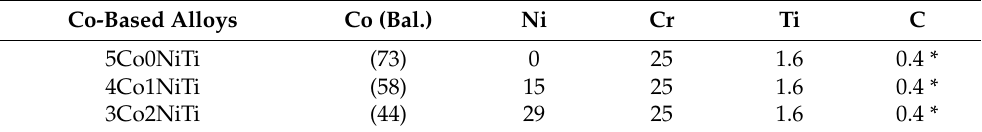
Table 2. Chemical compositions of the three Ni-richest alloys (confirmed by EDS full frame analysis; wt.%).